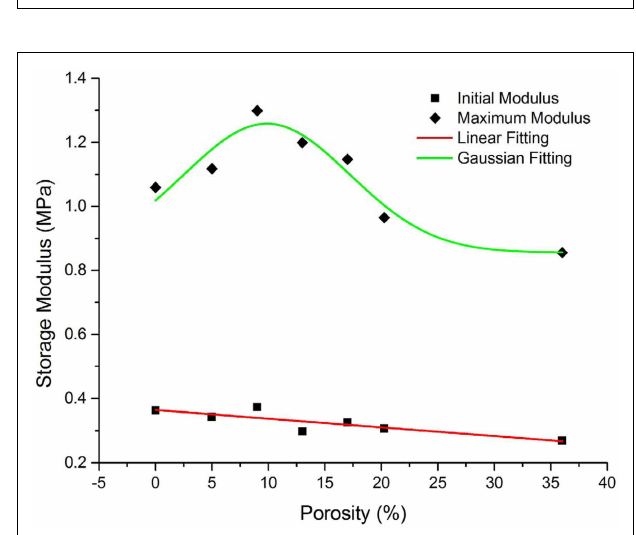
FIGURE 5 | Shear storage modulus of MRE samples under different magnetic fields .